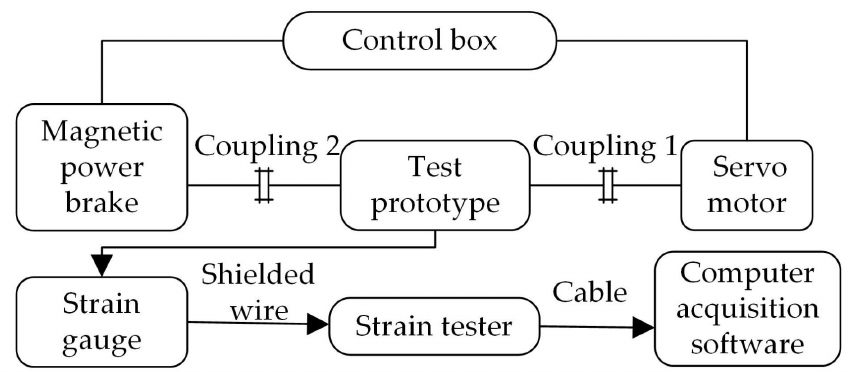
Figure 11. Basic schematic diagram of test